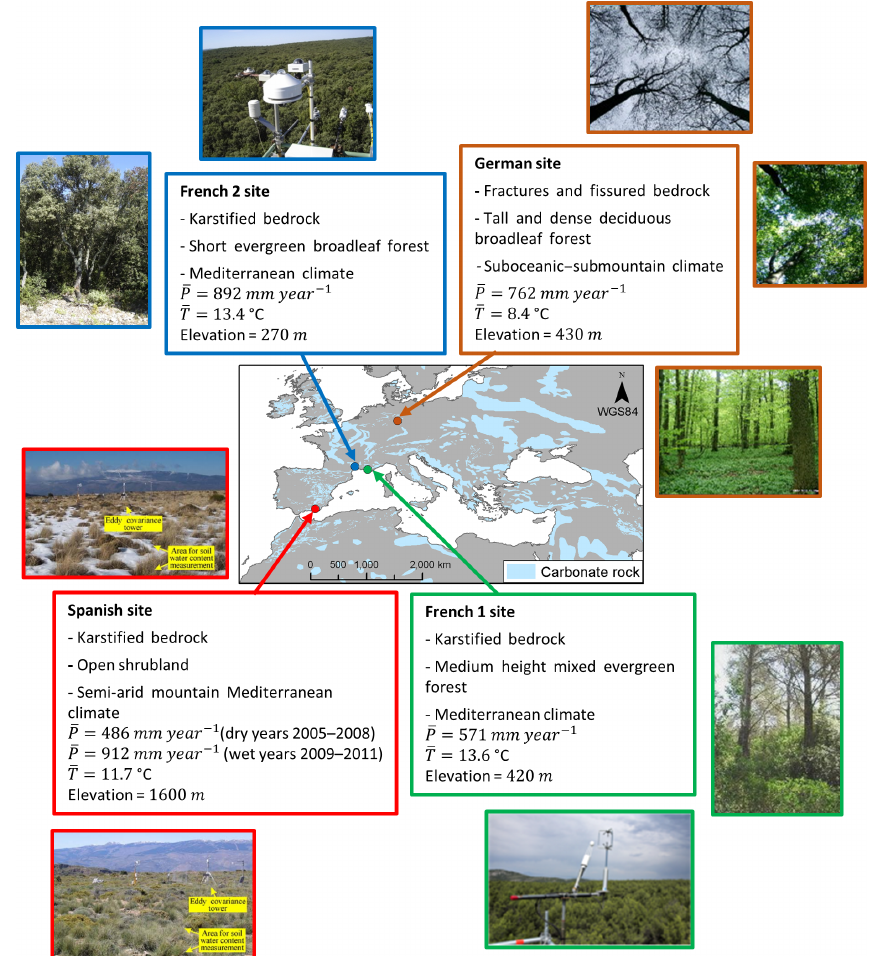
Figure 2. The four carbonate rock FLUXNET sites selected for the analyses. Mean annual precipitation ( P ) and mean annual temperature ( T ) were estimated over the period from 1 January 2001 to 17 December 2009 for the German site, 1 January 2006 to 31 December 2008 for the Spanish site (dry years), 1 January 2009 to 30 December 2011 for the Spanish site (wet years), 1 January 2010 to 30 December 2011 for the French 1 site and 1 April 2003 to 31 March 2009 for the French 2 site. Sources of the photos: Pinty et al. (2011) for the German site, Alcalá et al. (2011) for the Spanish site, http://www.gip-ecofor.org/f-ore-t/ fontBlanche.php (last access: 30 November 2018) for the French 1 site, http://puechabon.cefe.cnrs.fr/ (last access: 30 November 2018) for the French 2 site. Source of the carbonate rock and country map: Williams and Ford (2006) (country map obtained from Terraspace, Russian space